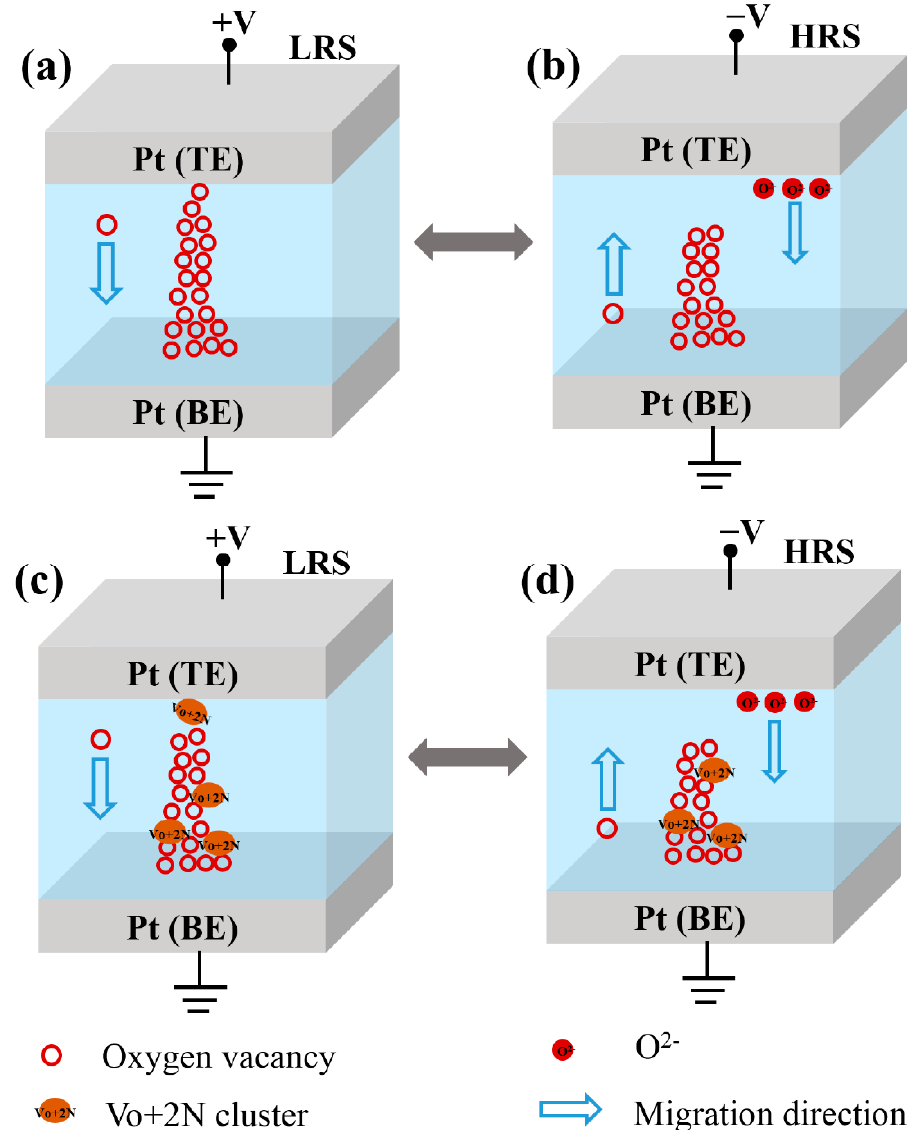
Figure 8. Schematic diagrams of CF formation and ruptures in LRS and HRS: ( a ), ( b ) Pt/NbO x /Pt memory device; ( c ), ( d ) Pt/NbO x :N/Pt memory device.